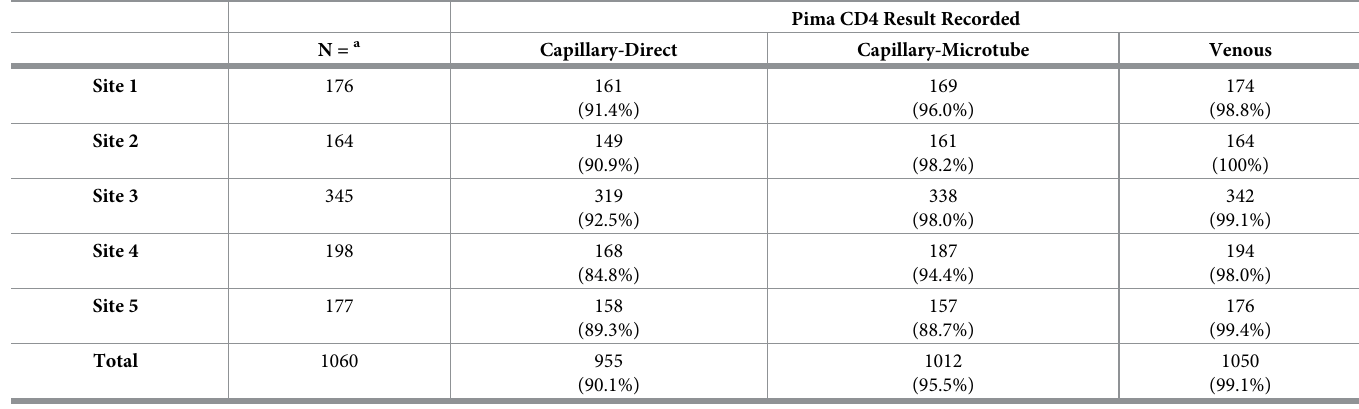
Table 4. Specimens type with recorded a Pima CD4 result per site.